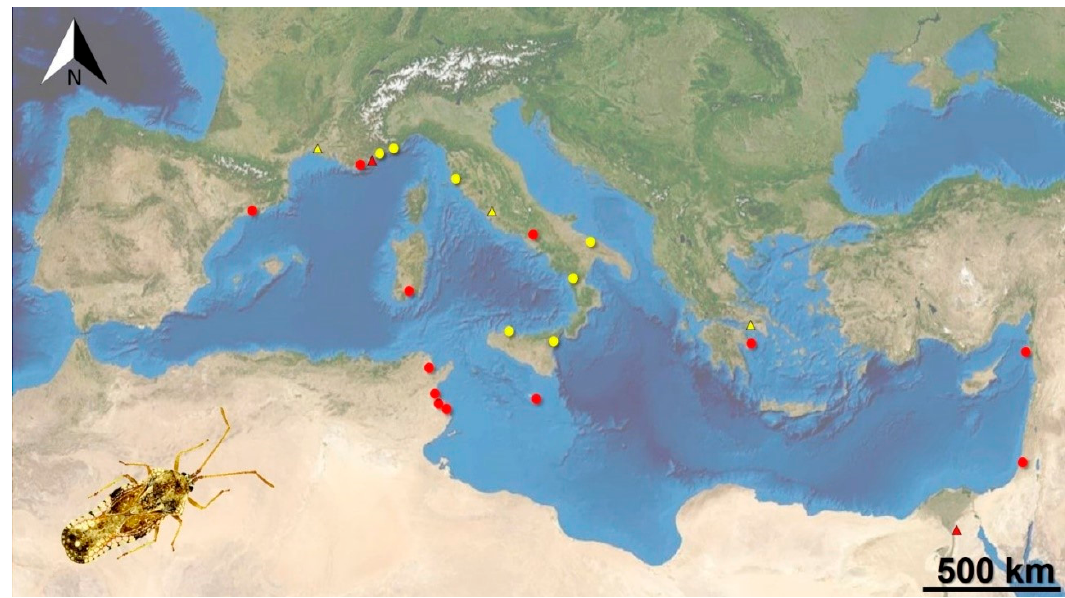
Figure 1. Map of known occurrences of the alien lacebug Corythauma ayyari in the Mediterranean basin. Dots represent collected specimens and triangles, indicating records from citizen science; the published occurrence records are in red, and the new data from our work are in yellow (US Dept of State Geographer, © 2020 Google, Map Data © 2020 AND Image Landsat / Copernicus).